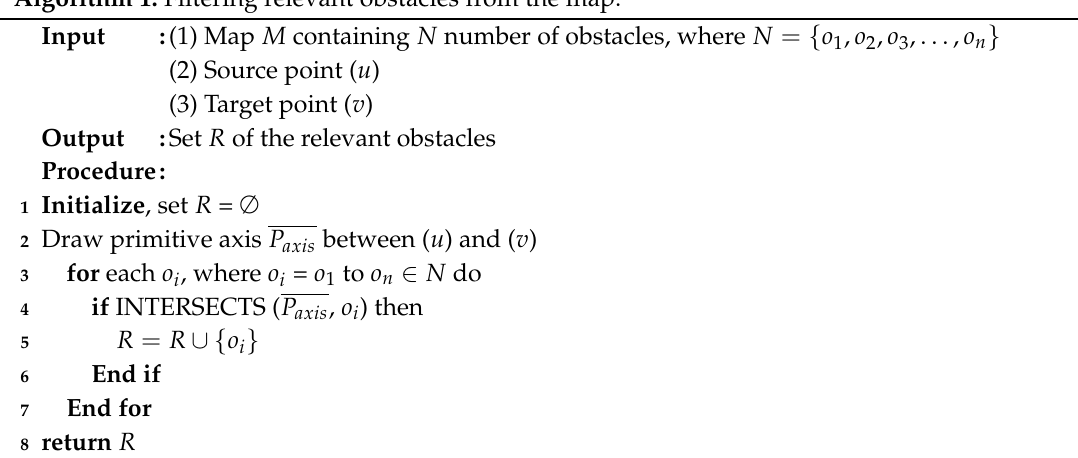
Algorithm 1: Filtering relevant obstacles from the